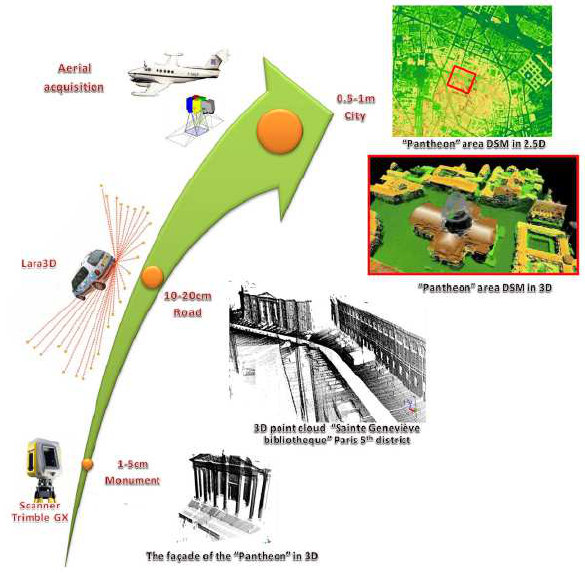
Fig. 1. Heterogeneous data collected in the 5th district in Paris, next to the Pantheon. Illustration of the role and level of representation of the three types of merged 3D data. We start with a high level of accuracy (1 to 5 cm) for data representing the remarkable buildings. We go to a medium resolution (10 to 20 cm) for the representation of streets and finish with a lesser accuracy (0.5 to 1 m) for the